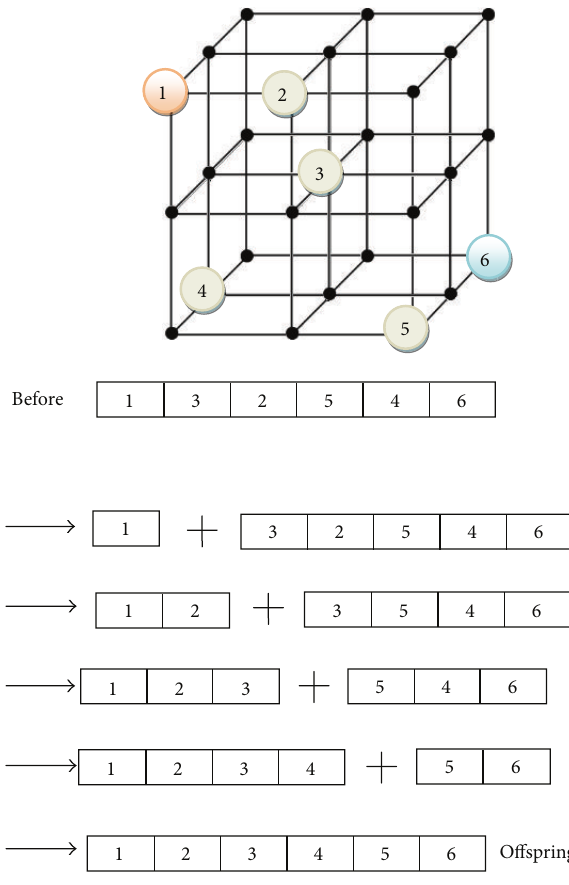
Figure 18: The idea of the proposed operator, Planar-NN. Table 4: The key parameters for the